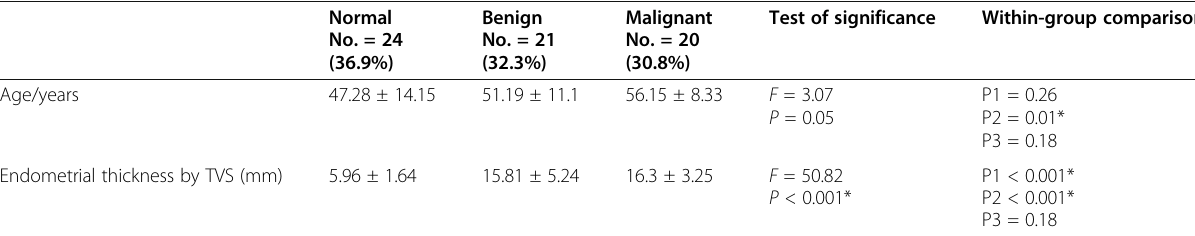
Table 1 Number of cases, age distribution, and endometrial thickness of the studied groups